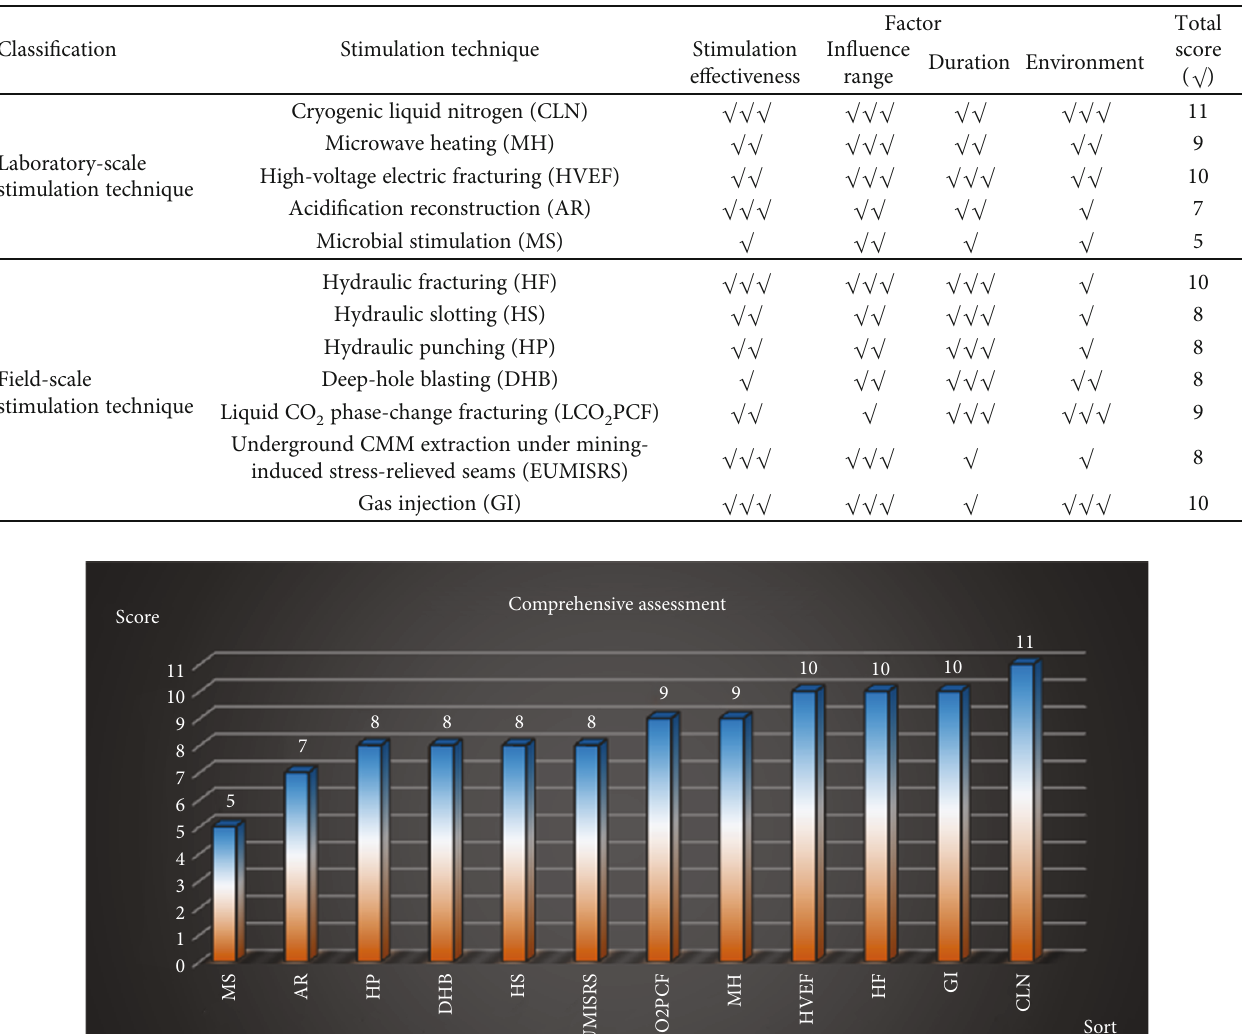
Table 6: Comprehensive assessment.